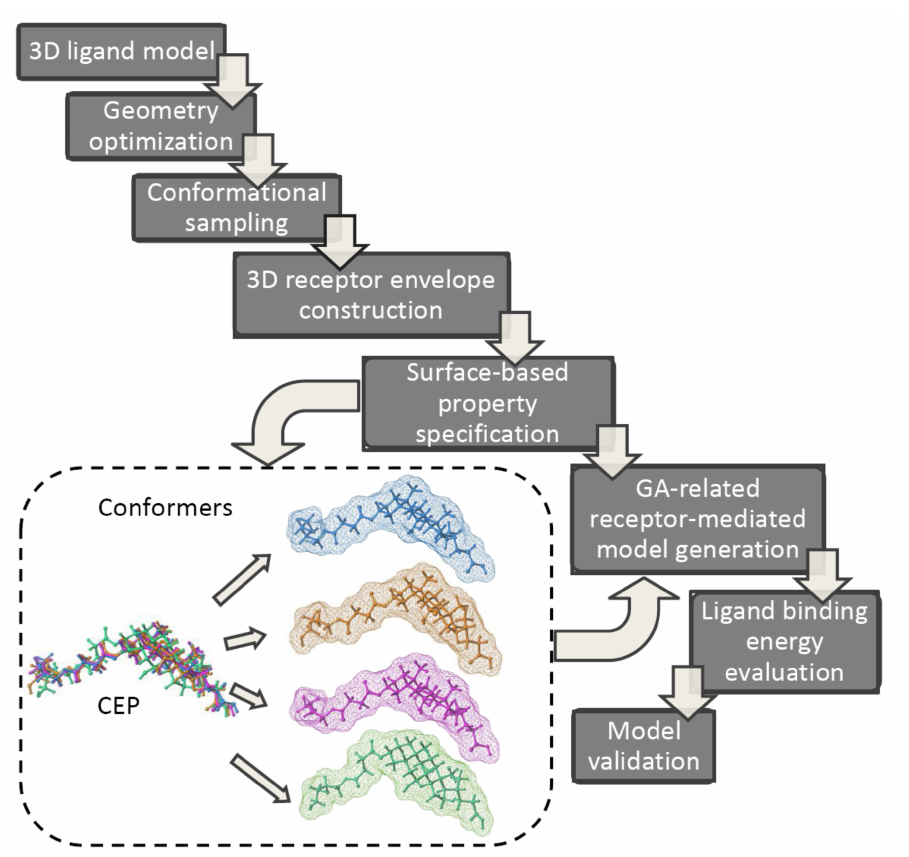
Figure 9. Quasi 4D-QSAR